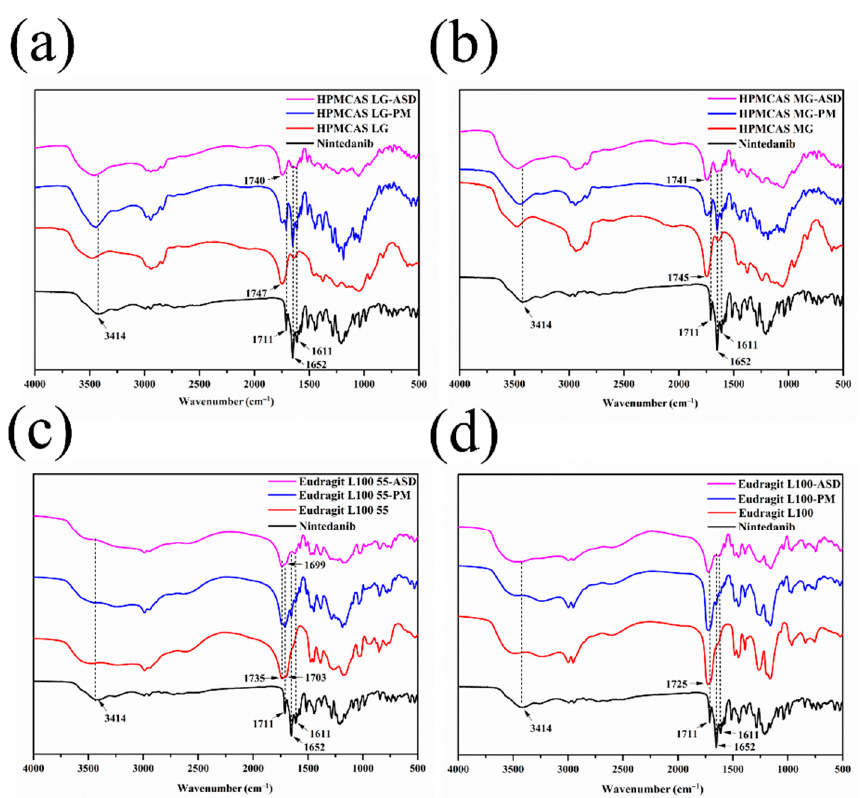
Figure 9. FT–IR spectra of nintedanib and samples with ( a ) HPMCAS LG, ( b ) HPMCAS MG, Figure 9. FT – IR spectra of nintedanib and samples with ( a ) HPMCAS LG, ( b ) HPMCAS MG, ( c ) ( c ) Eudragit L100 55, ( d ) Eudragit Eudragit L100 55, ( d ) Eudragit L100.